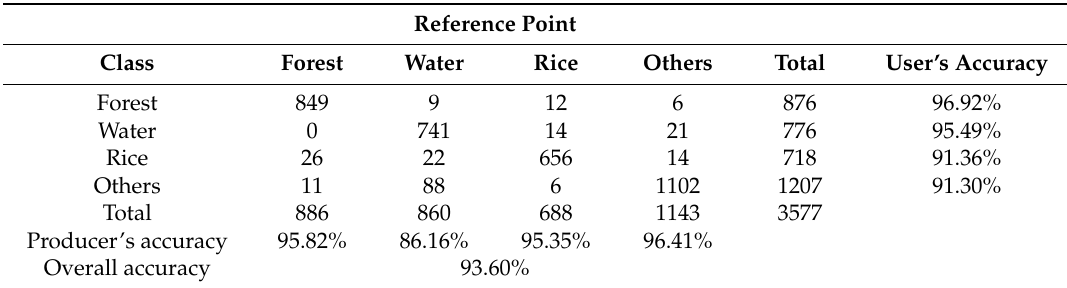
Table 3. Specifics of classification accuracy evaluation.